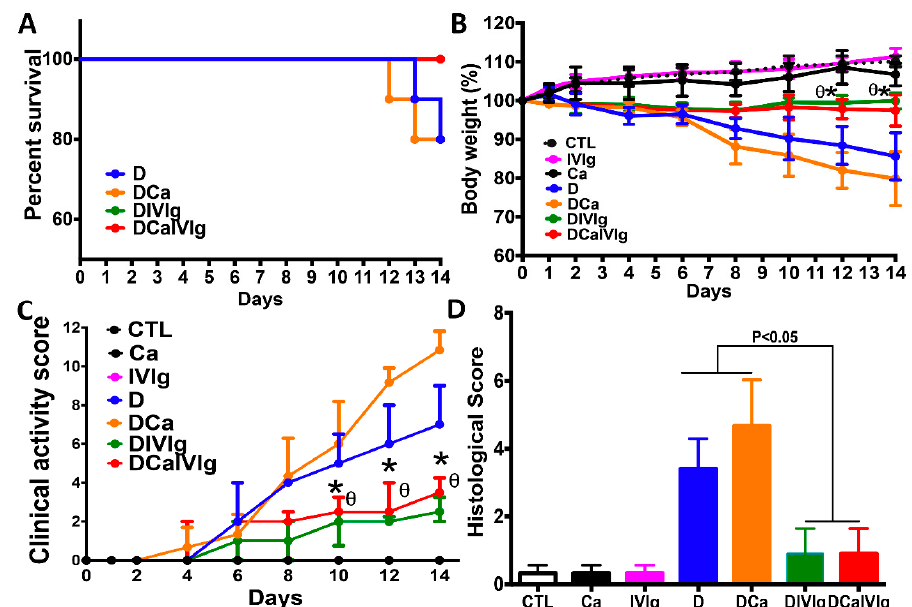
Figure 1. Effect of intravenous immunoglobulin (IVIg) treatment on the survival of mice, body weight, and inflammatory scores in the dextran sulfate sodium (DSS)-induced colitis model. ( A ) Mouse survival. Results are expressed as percent survival from the time of C. albicans challenge and DSS treatment. CTL, Ca, IVIg or D correspond to control groups receiving water, C. albicans , IVIg treatment or DSS, respectively. DCa corresponds to mice receiving C. albicans and treated with DSS. DIVIg corresponds to mice receiving DSS and treated with IVIg. DCaIVIg represents mice receiving C. albicans challenged with IVIg and treated with DSS. No mouse mortality was recorded in the Ca or IVIg groups, while DSS treatment induced 20% mouse mortality in groups D and DCa; ( B ) Body weight. Results are expressed as a percent; ( C ) Clinical analysis of DSS-induced colitis in mice after IVIg treatment. Clinical score was determined by assessing weight loss, change in stool consistency, and presence of gross bleeding. The clinical score ranged from 0 to 12 (each value corresponds to the mean value over 14 days per group). * p < 0.05 for DCaIVIg mice vs. DCa and D mice; ( D ) Histological scores. Scores range from 0 (no changes) to six (extensive cell infiltration and tissue damage). Data are the mean ± SD of 14 mice per group.